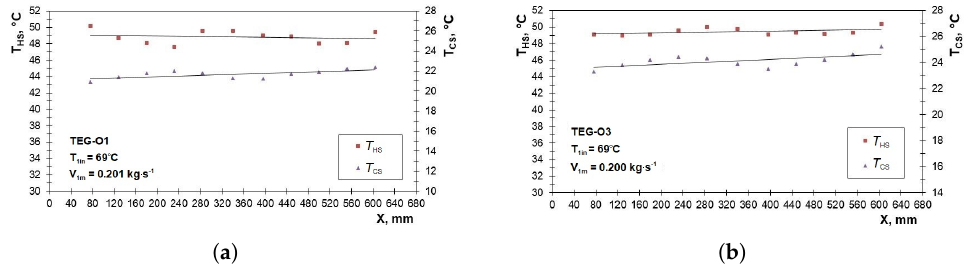
Figure 13. Temperature changes on the hot and cold side of the parallel walls of the exchangers in contact with the TEG plates, with selected hot side fluid circulations: ( a ) TEG-O1; ( b ) TEG-O3.